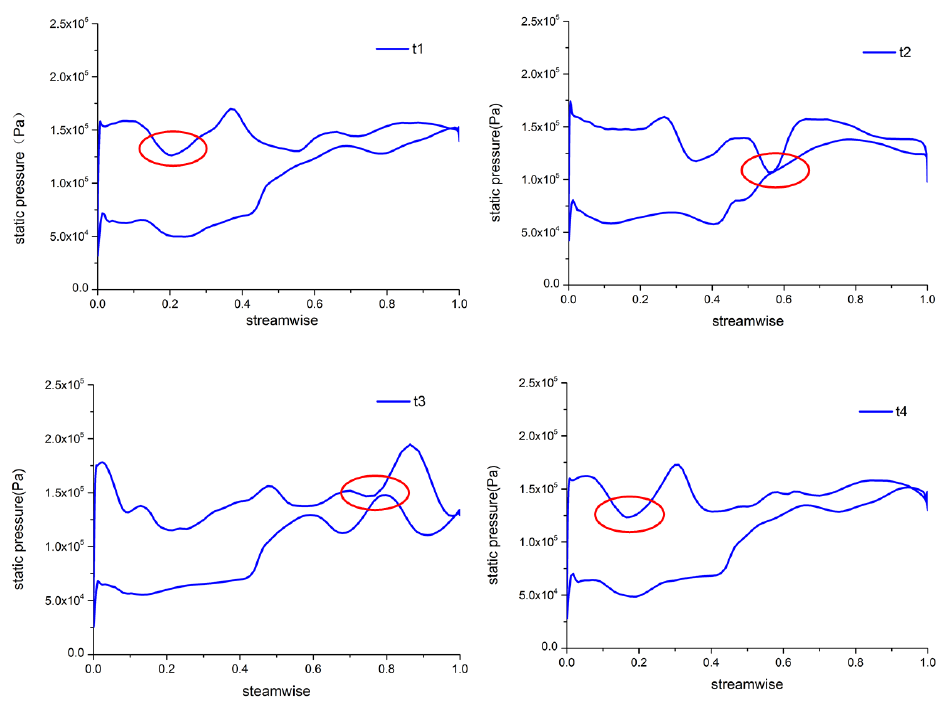
Figure 16. The tip load curves at 99% span in an unsteady period for 10% axial slots.